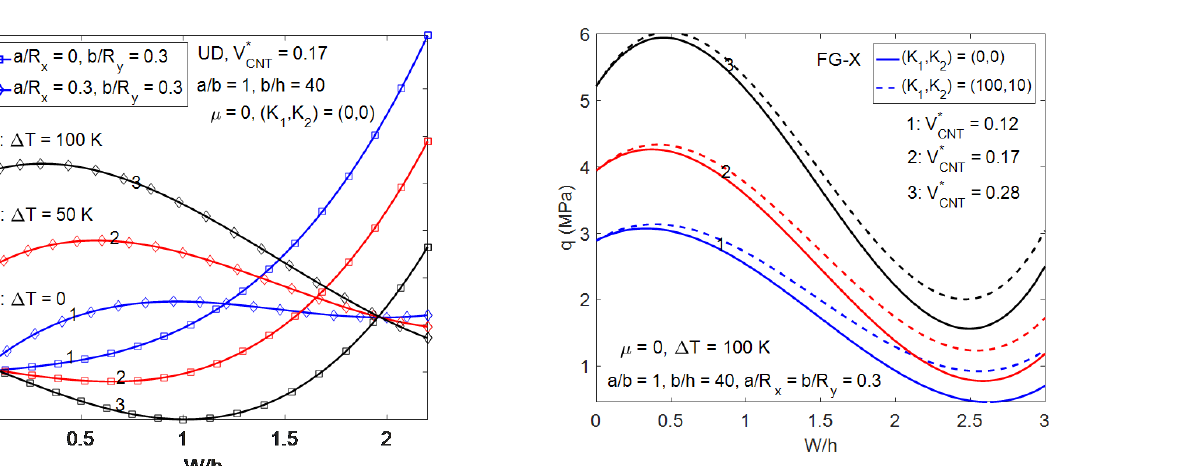
Fig. 13: Comparisons of the nonlinear thermomechanical response of CNTRC cylindrical and spherical panels with immovable edges.